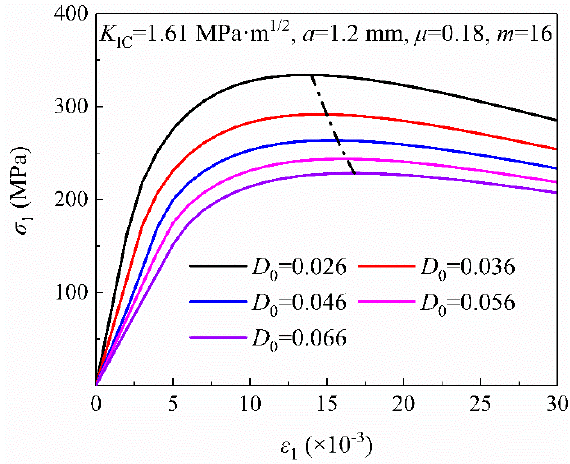
Figure 15. Effect of initial damage D 0 on stress-strain relationship.